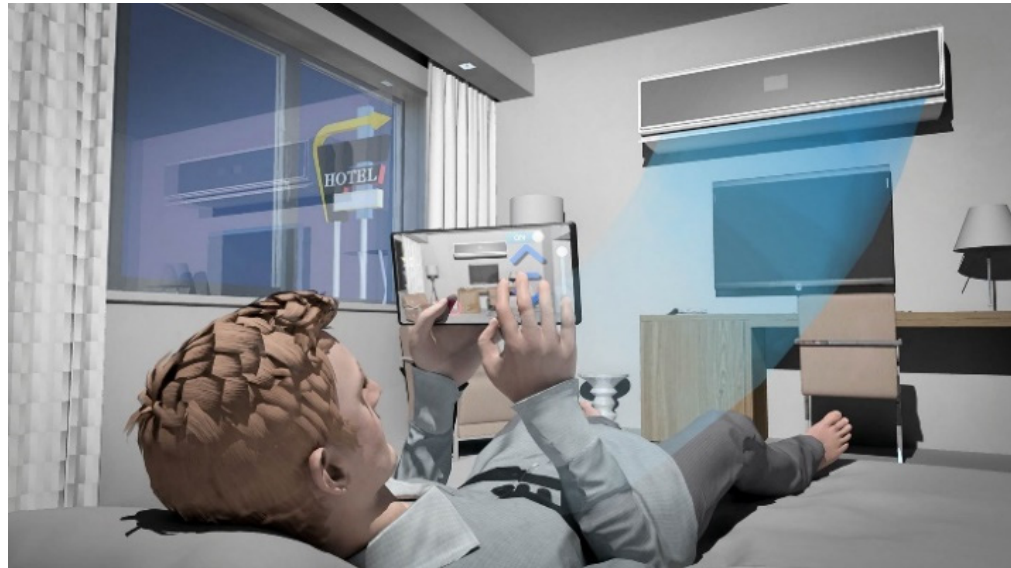
Figure 1. Use case scenario highlighting object-centric data management and intuitive interaction to enable “everywhere” augmented reality (AR) service through the Internet of Things (IoT) infrastructure.